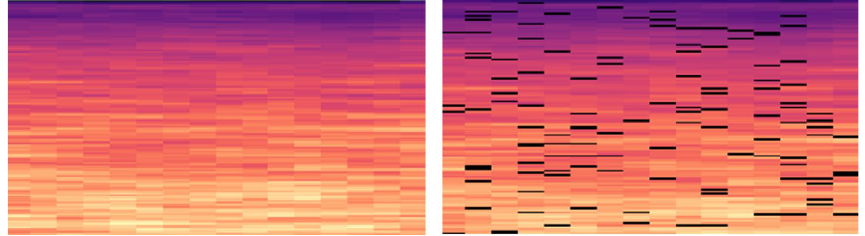
Figure 5. Coarse drop-out image-level augmentation applied to the